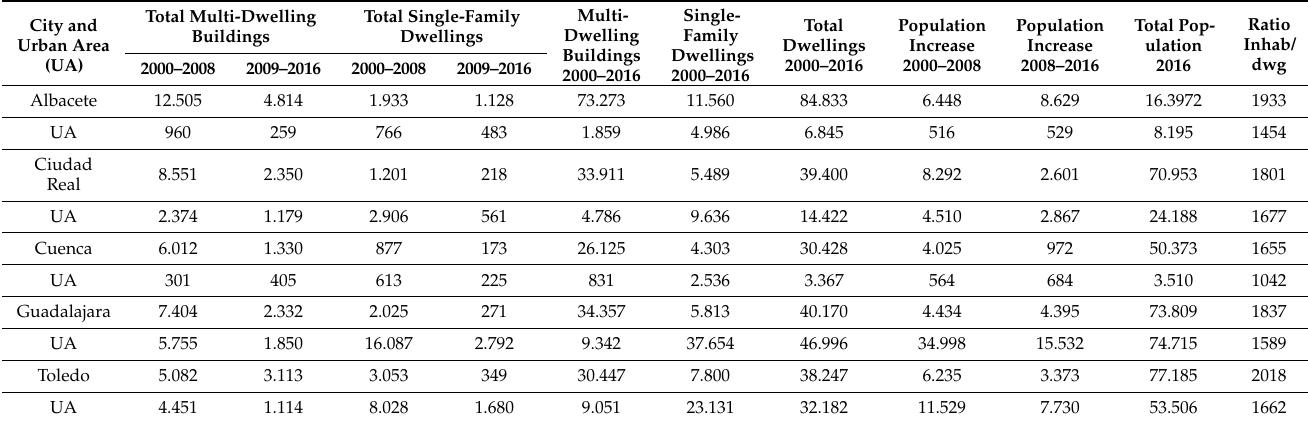
Table 3. Evolution of population and housing in the five provincial capitals of Castilla–La Mancha and their respective urban areas (2000–2016) 1 .